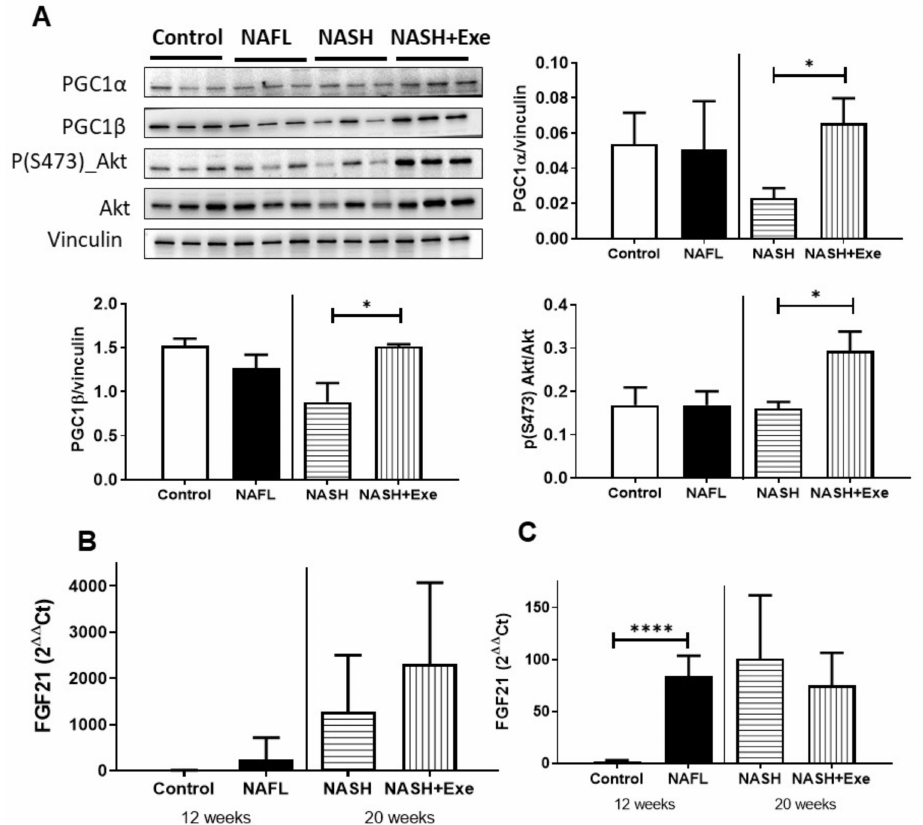
Figure 12. E ff ect of exercise on skeletal muscle. ( A ) Immunoblots of peroxisome proliferator-activated receptor gamma coactivator 1 α and 1 β - (PGC1 α , PGC1 β ) and phosphorylated Akt in skeletal muscle. ( B ) FGF21 mRNA expression in skeletal muscle. ( C ) FGF21 mRNA expression in liver. Vinculin served as the loading control (unpaired t -test; * p < 0.05; **** p < 0.0001). For more details of Western